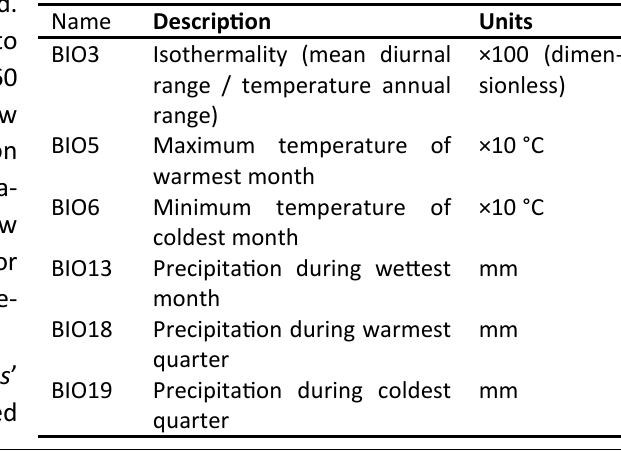
Table 1. Environmental variables used to model current potential and future northern distribution of the eastern red-backed salamander ( Plethodon cinereus